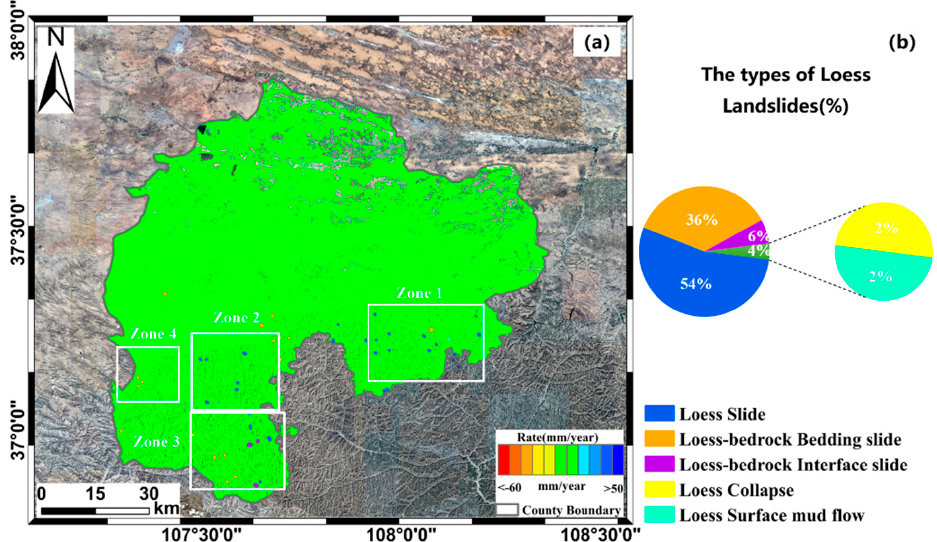
Figure 6. Annual deformation rate map and the pie chart of loess landslides types in Dingbian County detected by the Sentinel-1A SAR images. The polygons indicate the detected active landslides. ( a ) The deformation rate map in the line-of-sight (LOS) direction, where white rectangles indicate the detected landslides zones. ( b ) The pie chart for the loess landslide types in the study